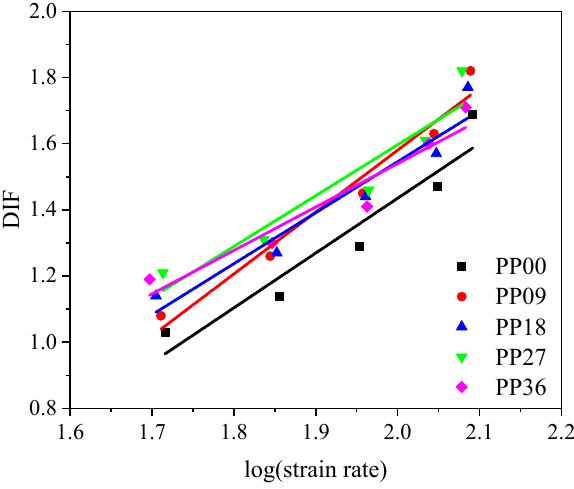
Figure 11. Fitted DIF curves of concrete reinforced with various polypropylene fibre content. Table 8. Summary of the fitted DIF equations for different mixtures.